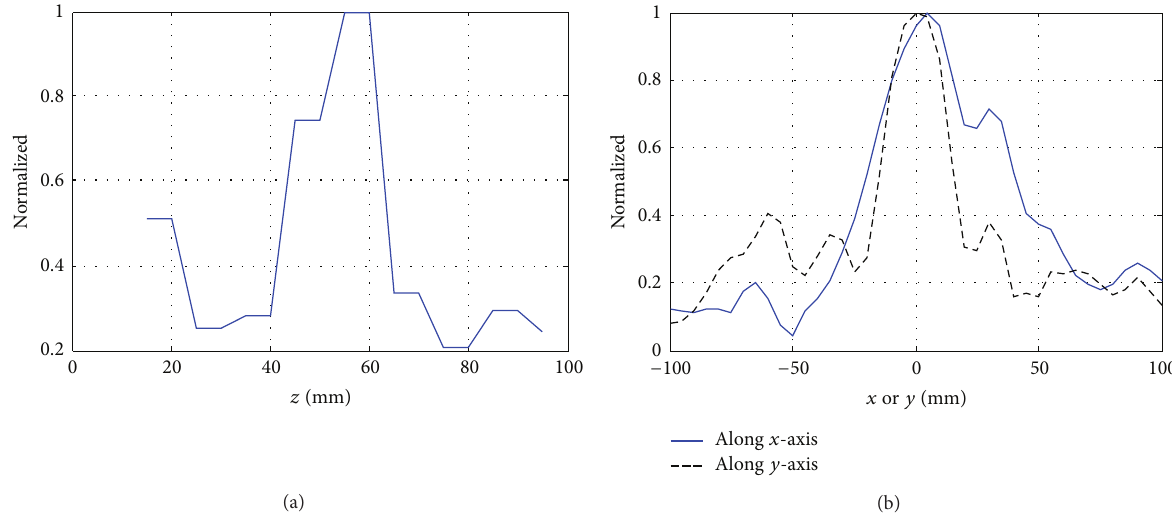
Figure 14: Normalized 1D magnitude of the reconstructed images along the range direction ( 𝑧 direction) and cross-range directions ( 𝑥 and 𝑦 directions) on the plane of the object in the experiment.